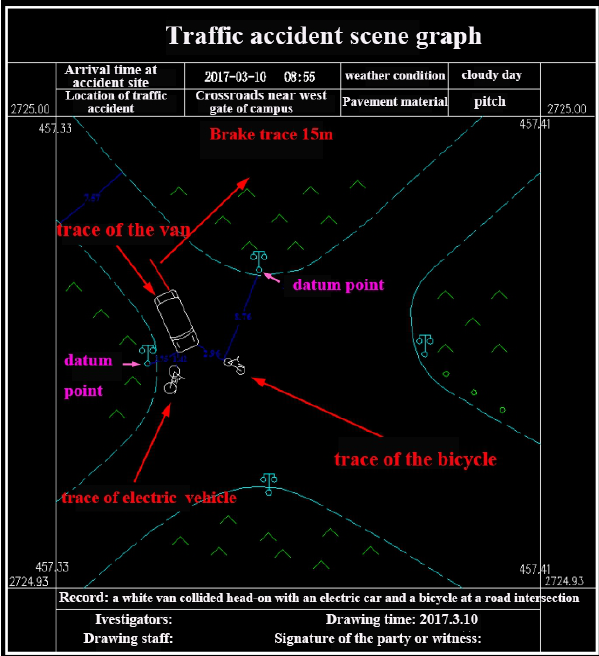
Figure 4. The digital line drawing of traffic accident scene